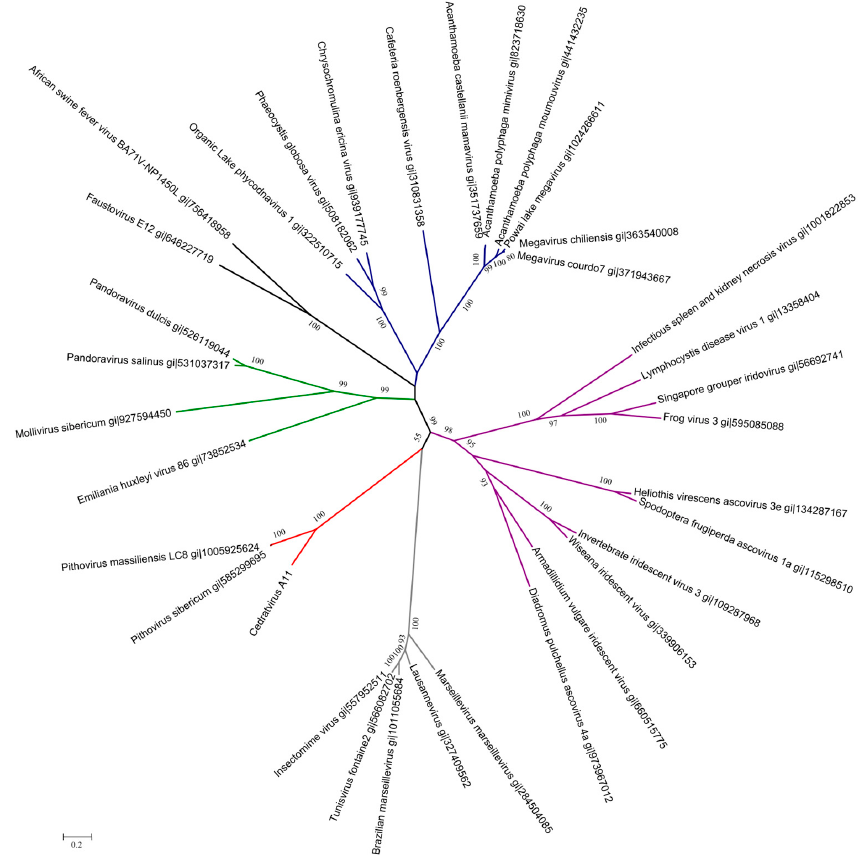
Figure 3. Unrooted tree based on DNA ‐ dependent RNA polymerase II subunit 1 amino acid sequences ; bootstrap values inferior to 0.5 (50%) were collapsed, branch length was applied; colors indicate family or viral groups: blue was used for Mimiviridae and an extended group including Phaeocystis globosa virus; purple for Ascoviridae ‐ Iridoviridae ; grey for Marseilleviridae ; red for Cedratvirus and pithoviruses; green for Phycodnaviridae , pandoraviruses, and Mollivirus sibericum and black color for African swine fever virus and Faustovirus.